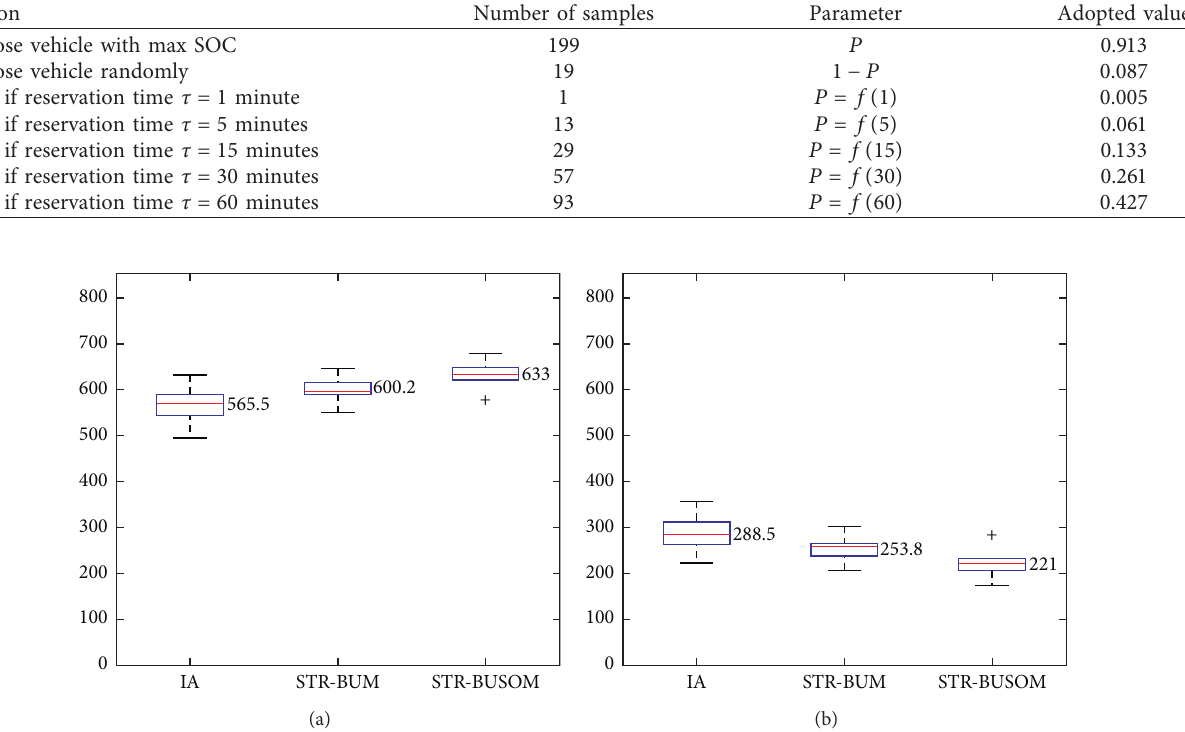
Table 3: Parameter calibration.